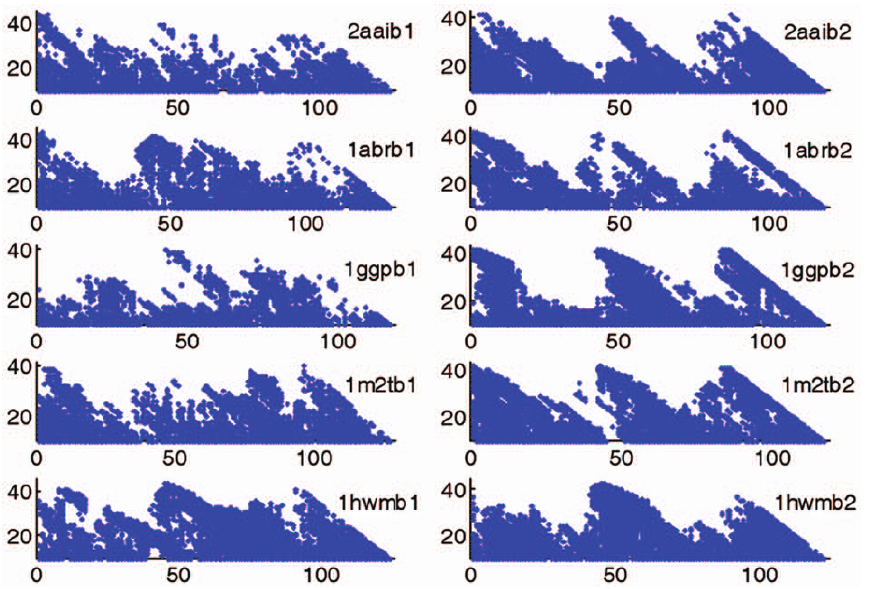
Figure 1. The MRPs of two domains in five representative protein chains. Column one is for the first domains and column two is for the second domains. doi:10.1371/journal.pone.0014138.g001 Key structural residues of three-fold repetitions